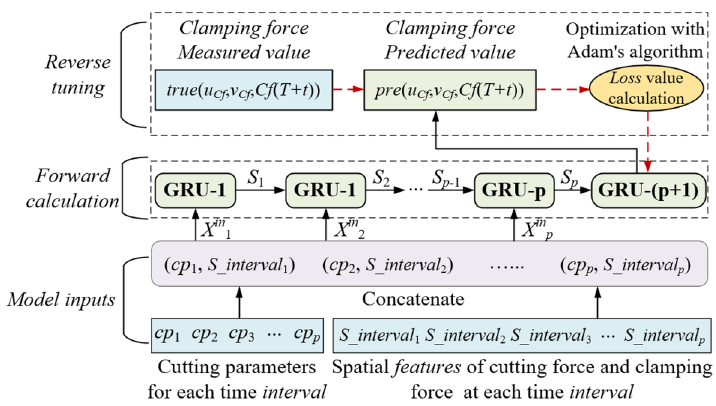
Figure 6. GRU network-based temporal correlation learning